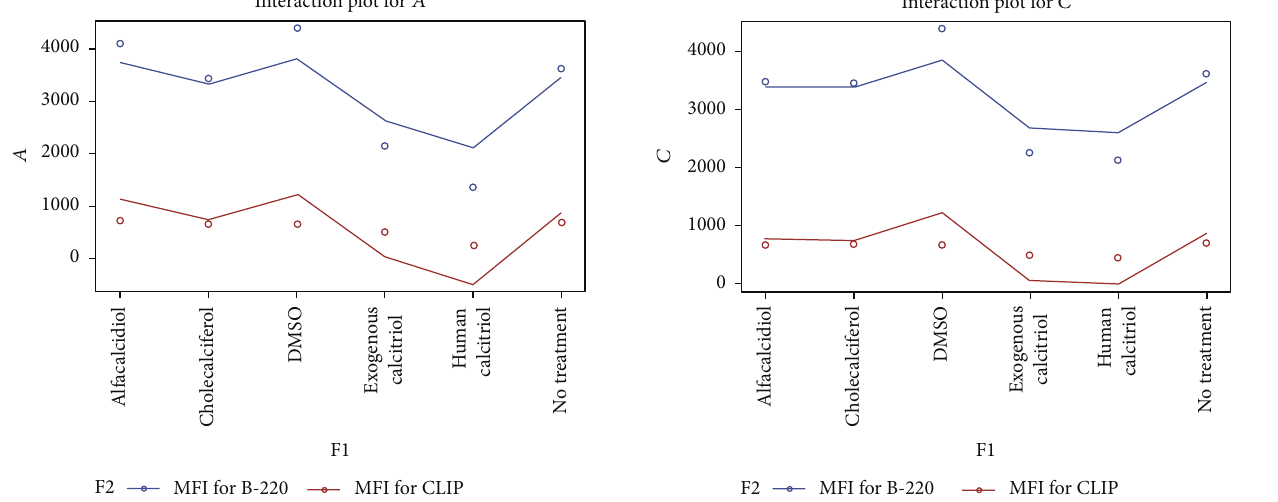
Figure 4: This figure compares the impact of the various vitamin D compounds at 0.1 mg/dL on the density of cell surface CLIP expression and B220 subsets of B cells 15hrs after treatment using the vitamin D3 compounds versus nontreatment or DMSO. These results suggest that the active formulation of vitamin D3 once again leads to a statistically significant reduction in CLIP expression on polyclonally activated splenic B cells even at a higher concentration of 10 mg/dL. Administration of the human calcitriol of vitamin D3 ( 𝑃 = 0.0181 ) resulted in the greatest overall reduction in the MFI (257.3 versus a baseline of 701.1 and 667.7 for the control) of CLIP expression on mitogen stimulated B cells.